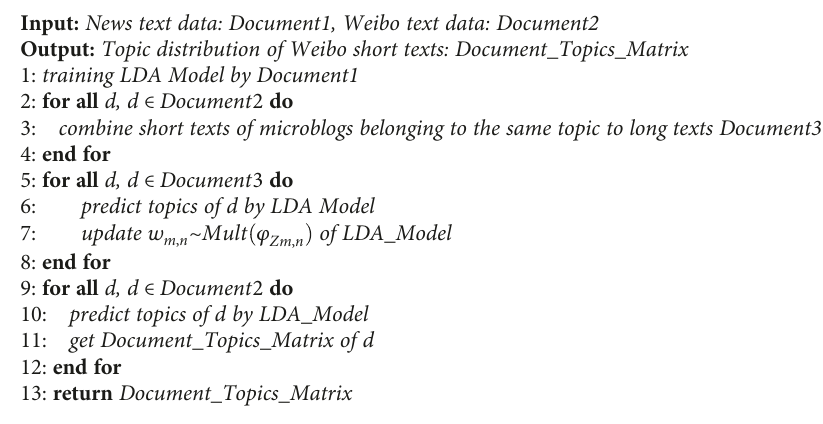
Algorithm 2: Improved LDA topic model based on the Weibo text.